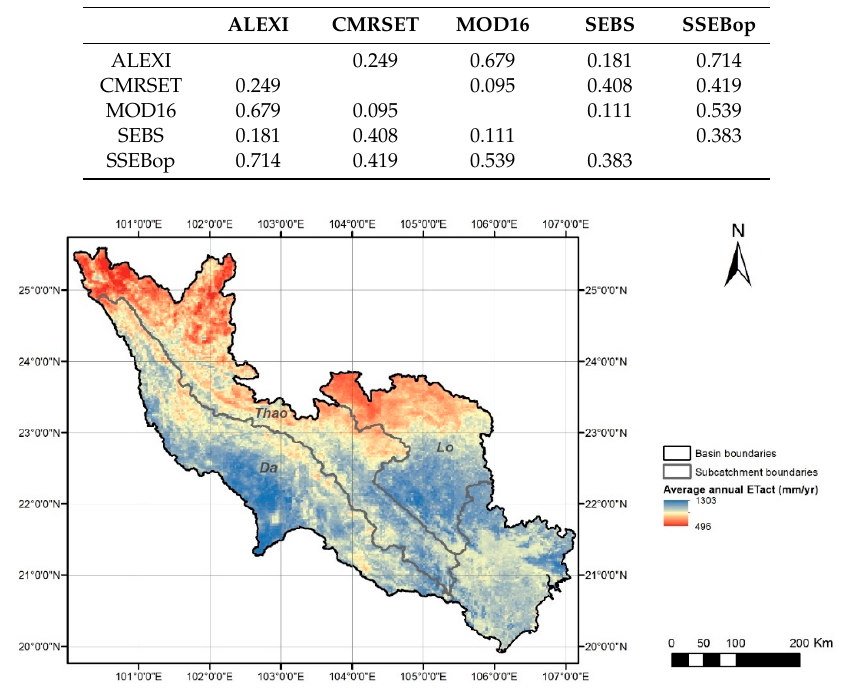
Figure 7. Annual ET act averaged in the Red River Basin for the period January 2003–December